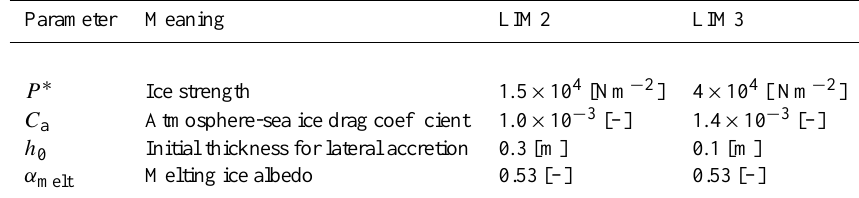
Table 1. Main sea ice parameters and their values in the two configurations discussed in the